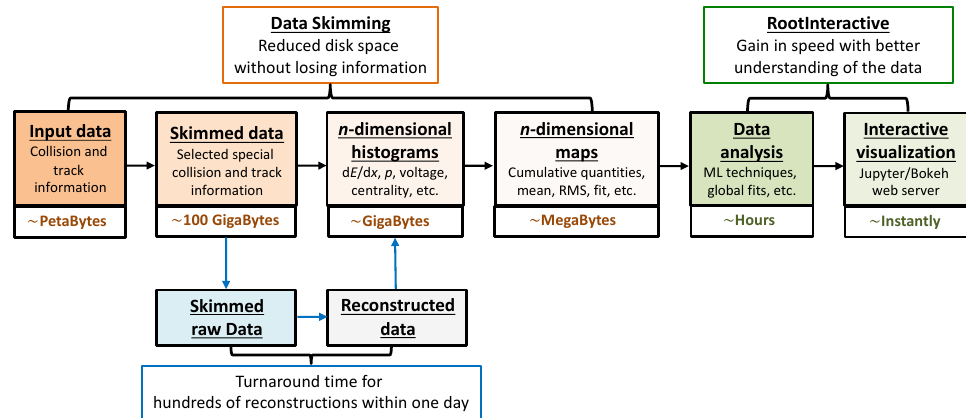
Figure 3. Workflow of the skimmed data and RootInteractive tool.